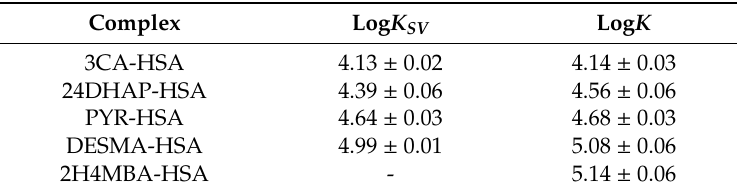
Table 1. Decimal logarithmic values ( ± SEM) of Stern-Volmer quenching constants ( K SV ; unit: L / mol) and binding constants ( K ; unit: L / mol) of albumin-ligand complexes. Means and SEM are derived from three independent experiments. SEM values regarding the fitting to individual data series with Hyperquad software did not exceed 0.02.